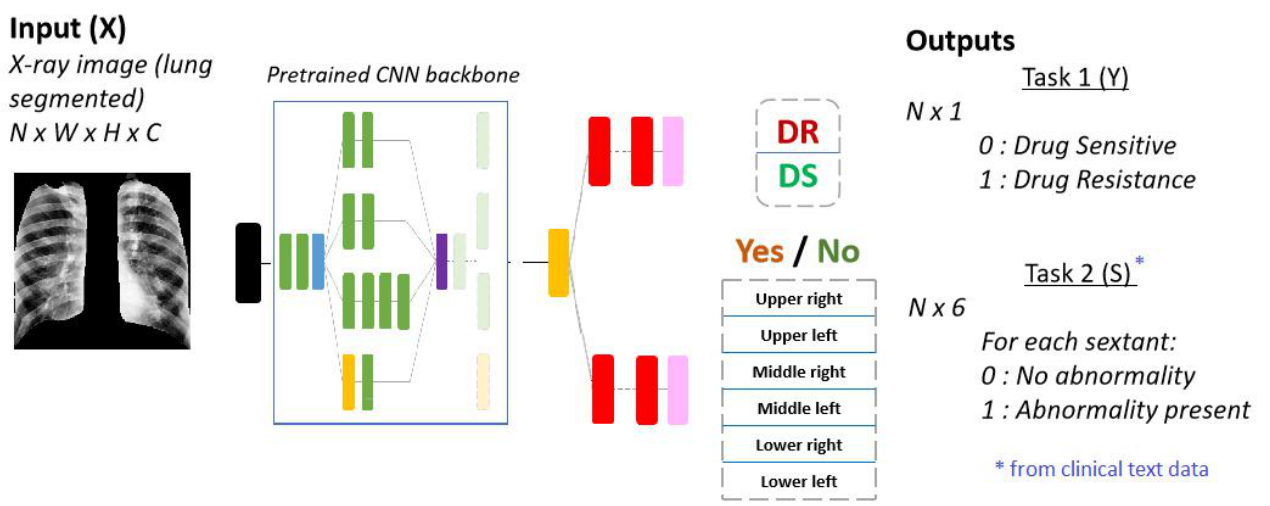
Figure 6. Multi-output network with the same pretrained backbone (ResNet18) for the additional task of abnormal sextant classification. The data used for this task is multi-modal. The inputs to the network are the chest X-ray images, whereas the labels for abnormal sextants are derived from the clinical text data described in Section